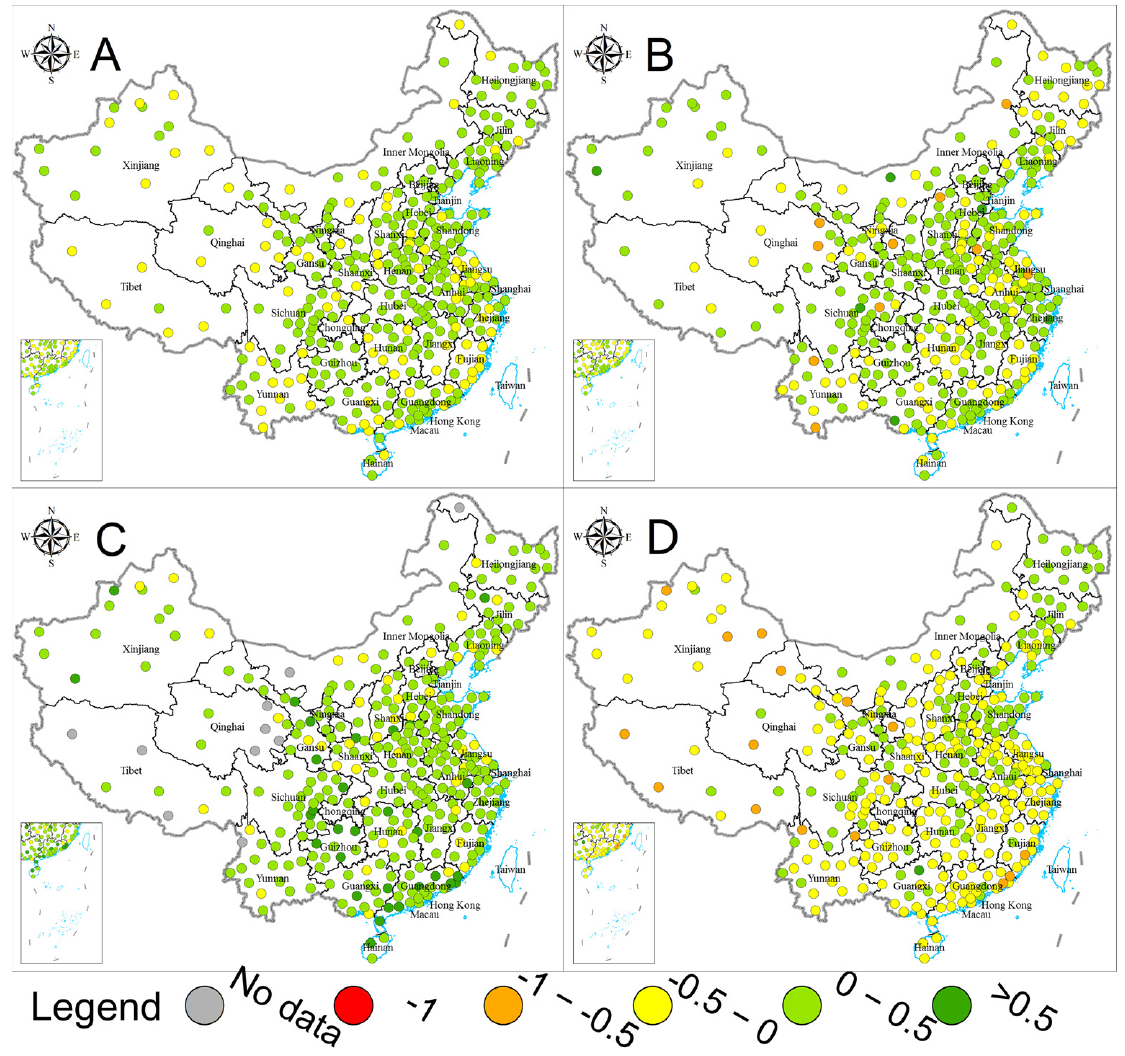
Figure 5. Water sustainability development between 2015 and 2021 by city (( A ) for water sustainability, ( B ) for water quality, ( C ) for water infrastructure, and ( D ) for water conservation and rational utilization).